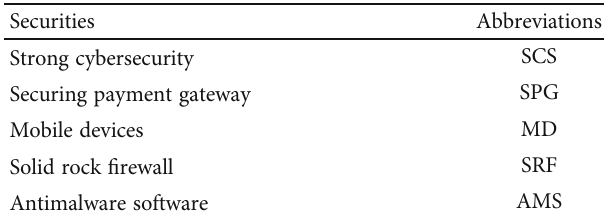
Table 1: Summary of